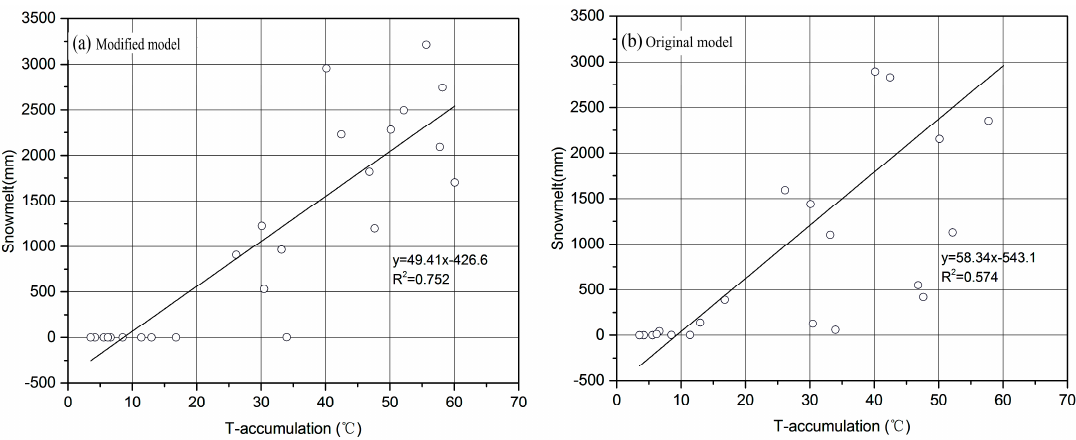
Figure 9. Correlation between monthly snow melting and AT ( a ) using the modified model and ( b ) using the original